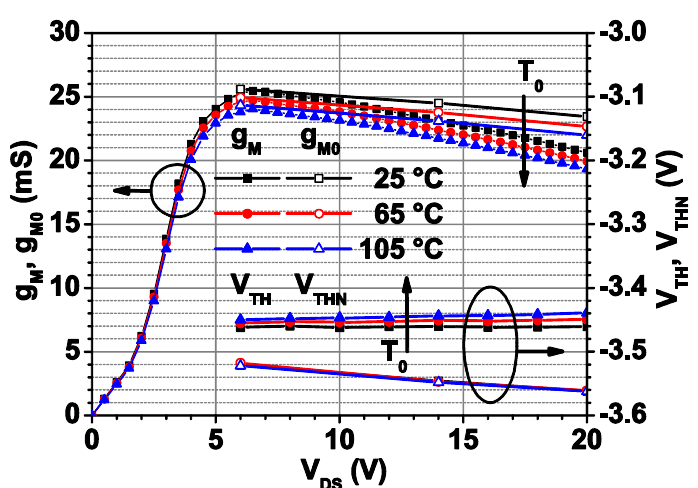
Figure 3. Output I-V characteristics for V GS = 0 V at various T 0.